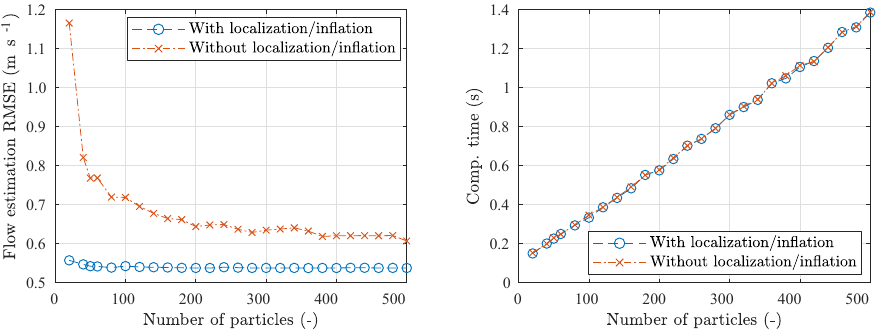
Figure 3. This figure shows the estimation performance and computational cost (parallelized, 8 cores) of the EnKF for a range of ensemble sizes, with and without inflation and localization. Great improvement is seen for estimation accuracy, at no additional computational cost. The simulation scenario is described in detail in Sect. 4.2, and the results presented here are rather meant as an